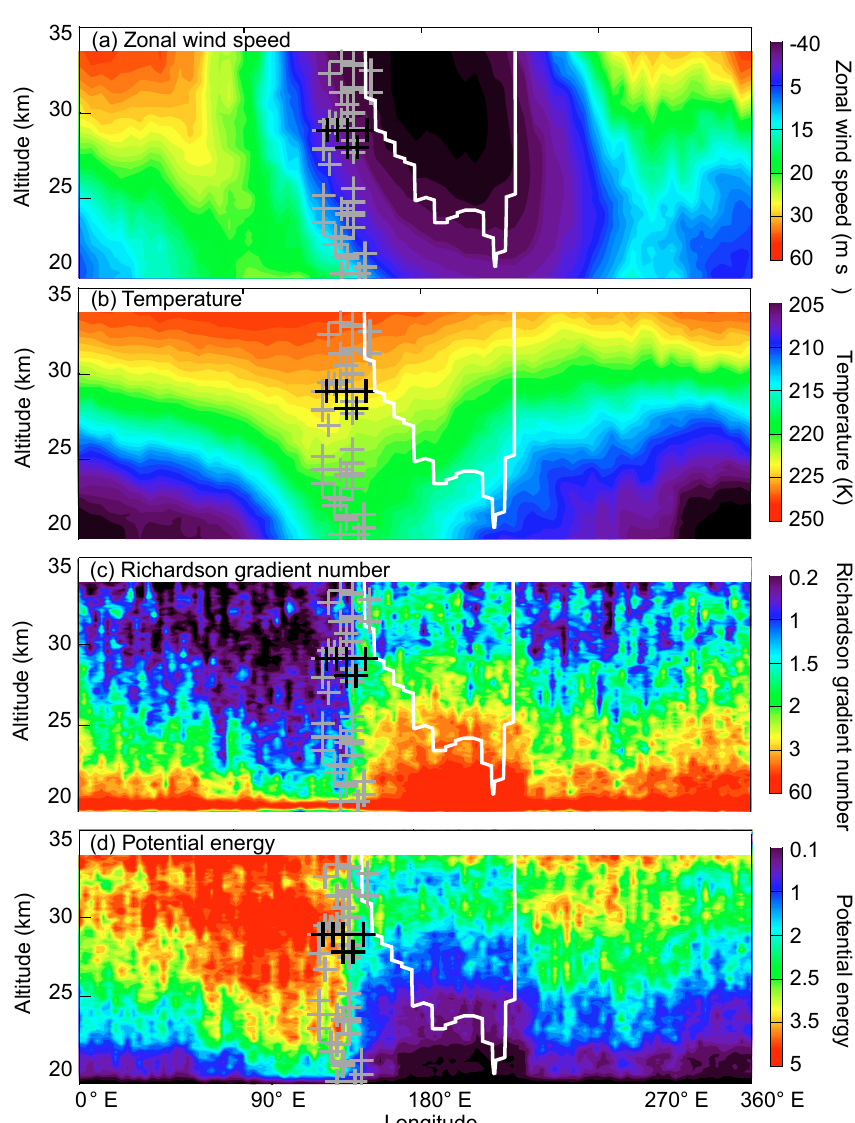
Figure 7. Vertical profiles of the zonal wind speed (a) , temperature (b) , Richardson gradient number (c) , and potential energy (d) for the DJF season and the 35 ◦ –45 ◦ N latitudinal belt. The crosses represent the height of maximum σ 2 values (black represents profile means; grey represents individual profiles). The white line depicts the borders of the region where the vertical rotation of the wind direction exceeds 180 ◦ .